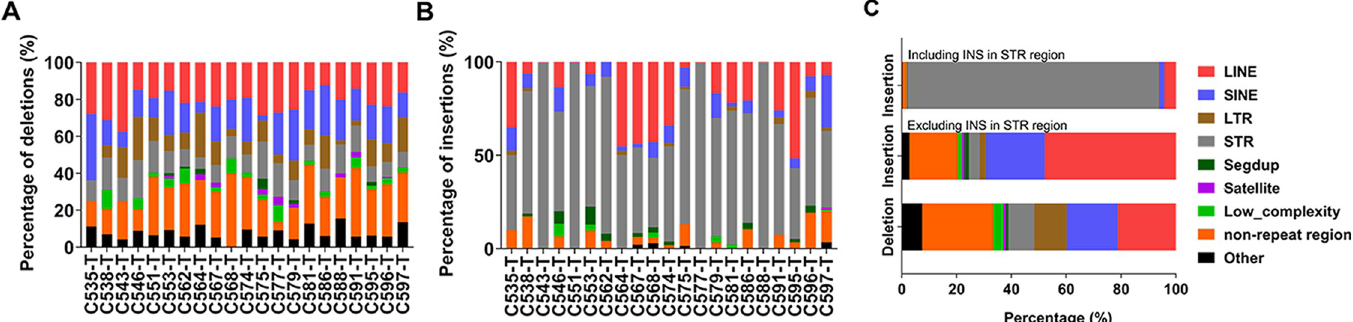
Fig 3. Sequence analysis of somatic deletions/ insertions. (A and B) The genomic context of somatic deletions (A) and insertions (B) in each sample obtained from sequence analysis using RepeatMasker. Segdup, segment duplications; Satellite, satellite repeats; Low_complexity, low complexity repeats. (C) The components and proportions of deletions and insertions including or excluding insertions in STR